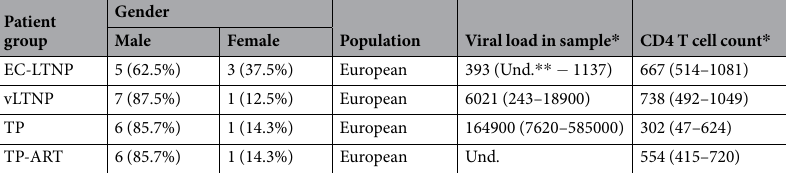
Table 1. Main clinical characteristics of the patient groups included in the analysis. * Mean